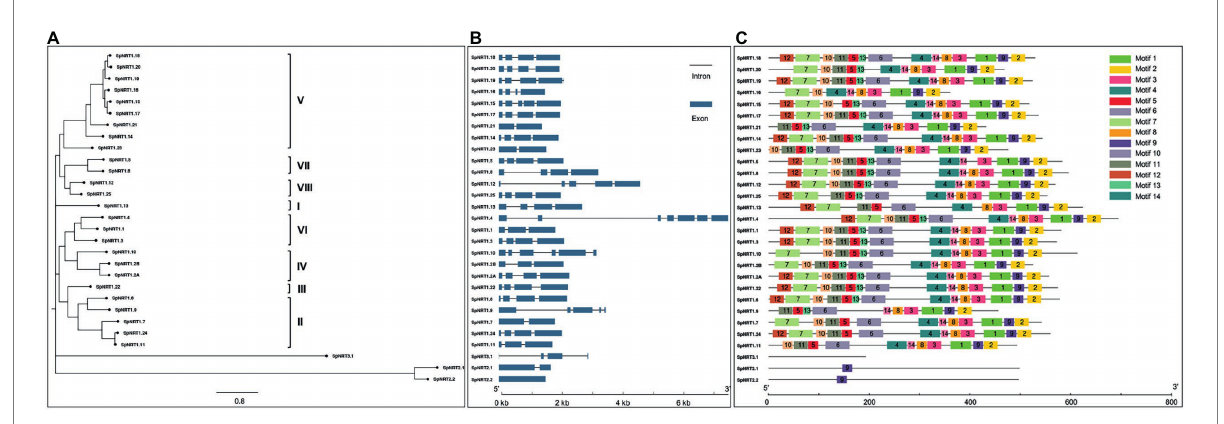
FIGURE 1 SpNRTs gene structure analysis and the conserved motifs in the SpNRT protein families. (A) Neighbor-joining method was used to construct a phylogenetic tree of SpNRT proteins by MEGA X software. All the parameters adopted the reported default values (Stecher et al., 2020). (B) Gene structure analysis of SpNRT s. The sequences of SpNRTs and gene structure information were obtained from the Ensemble plants database, and the GSDS program was used to display Gene structure (http://gsds.cbi.pku.edu.cn; Hu et al., 2015). (C) The predicted conserved motif of SpNRT proteins by the MEME program http://meme-suite.org/tools/meme (Bailey and Elkan, 1994; Bailey et al., 2015). TBtools was used to display the motif location (Chen et al.,